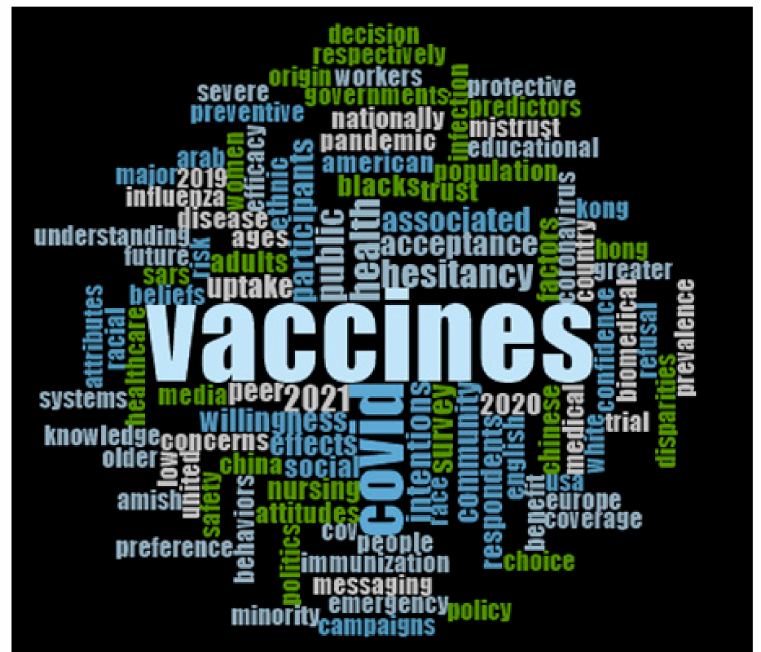
Figure 2. Word cloud displaying 100 of the most frequent words in the titles and abstracts of the 71 final set of